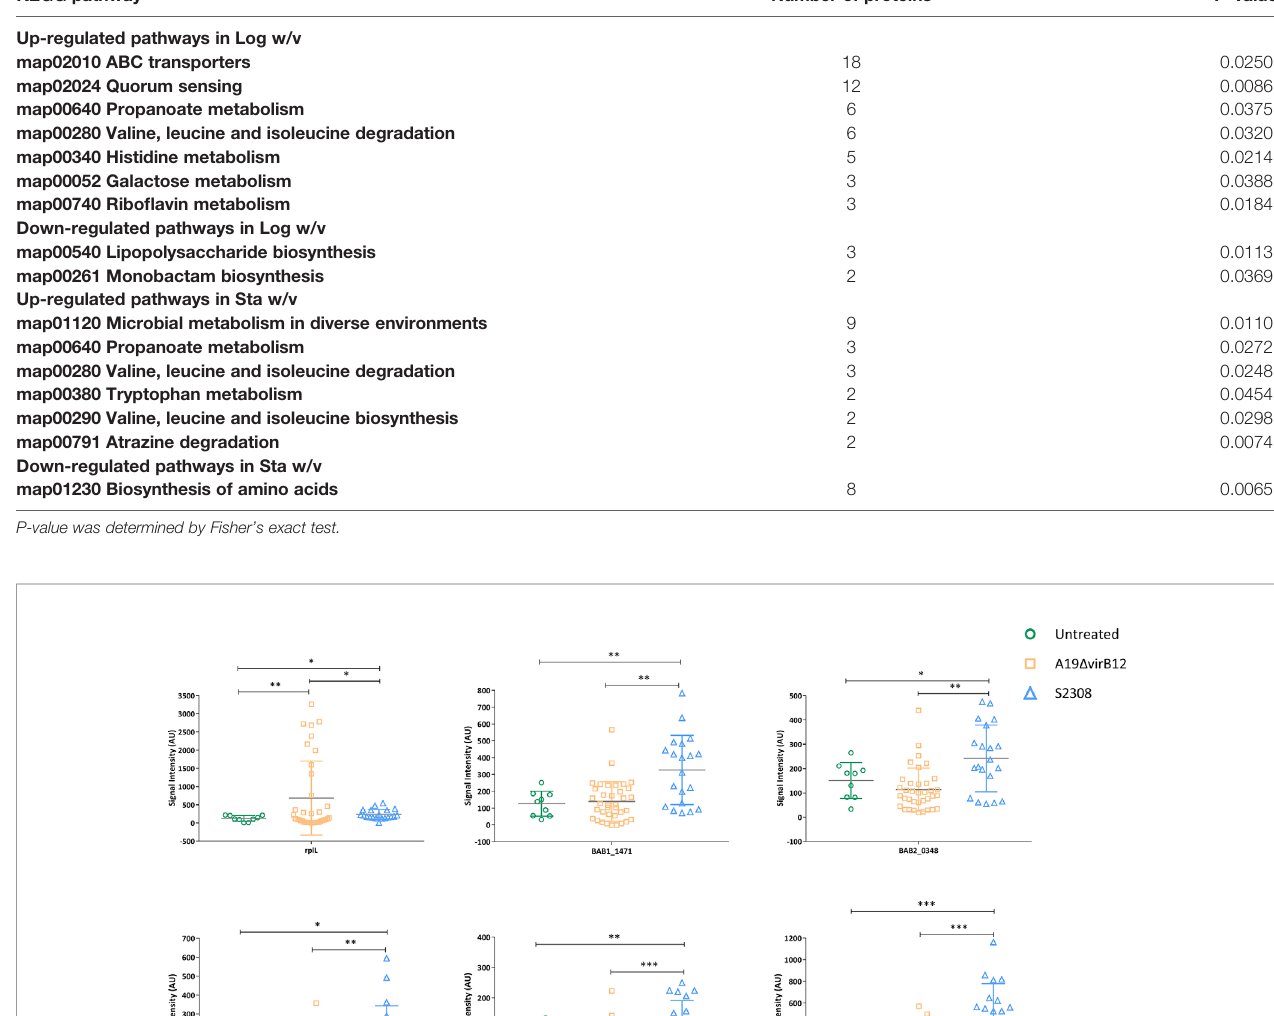
TABLE 3 | KEGG pathways enrichment for DEPs in the logarithmic and stationary phases ( P -value <0.05). KEGG pathway